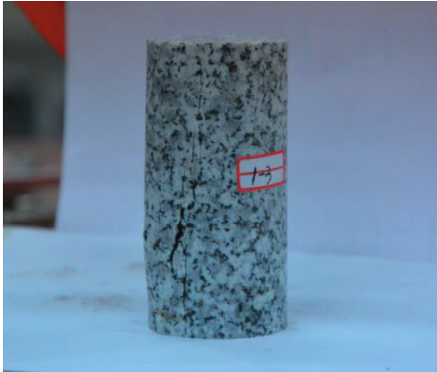
Figure 6: The compressed result.